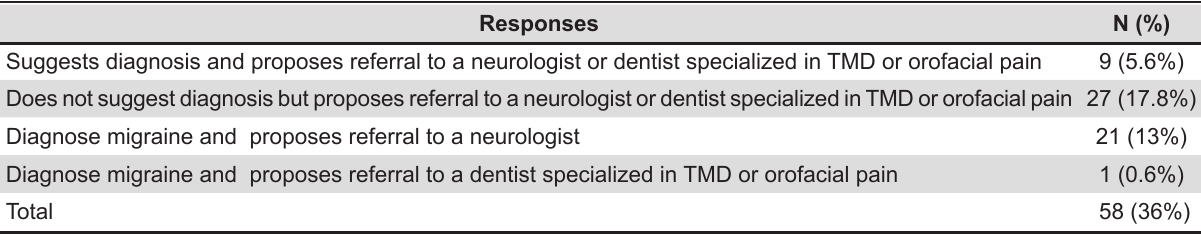
Table 1- Valid responses considered to be